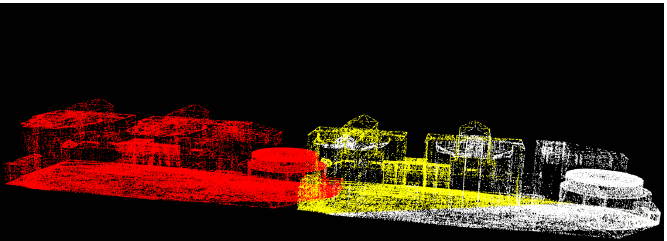
Figure 9. Registration result. The white point set is the transformed source point set. It overlaps with the point set generated from the edited geometry M e